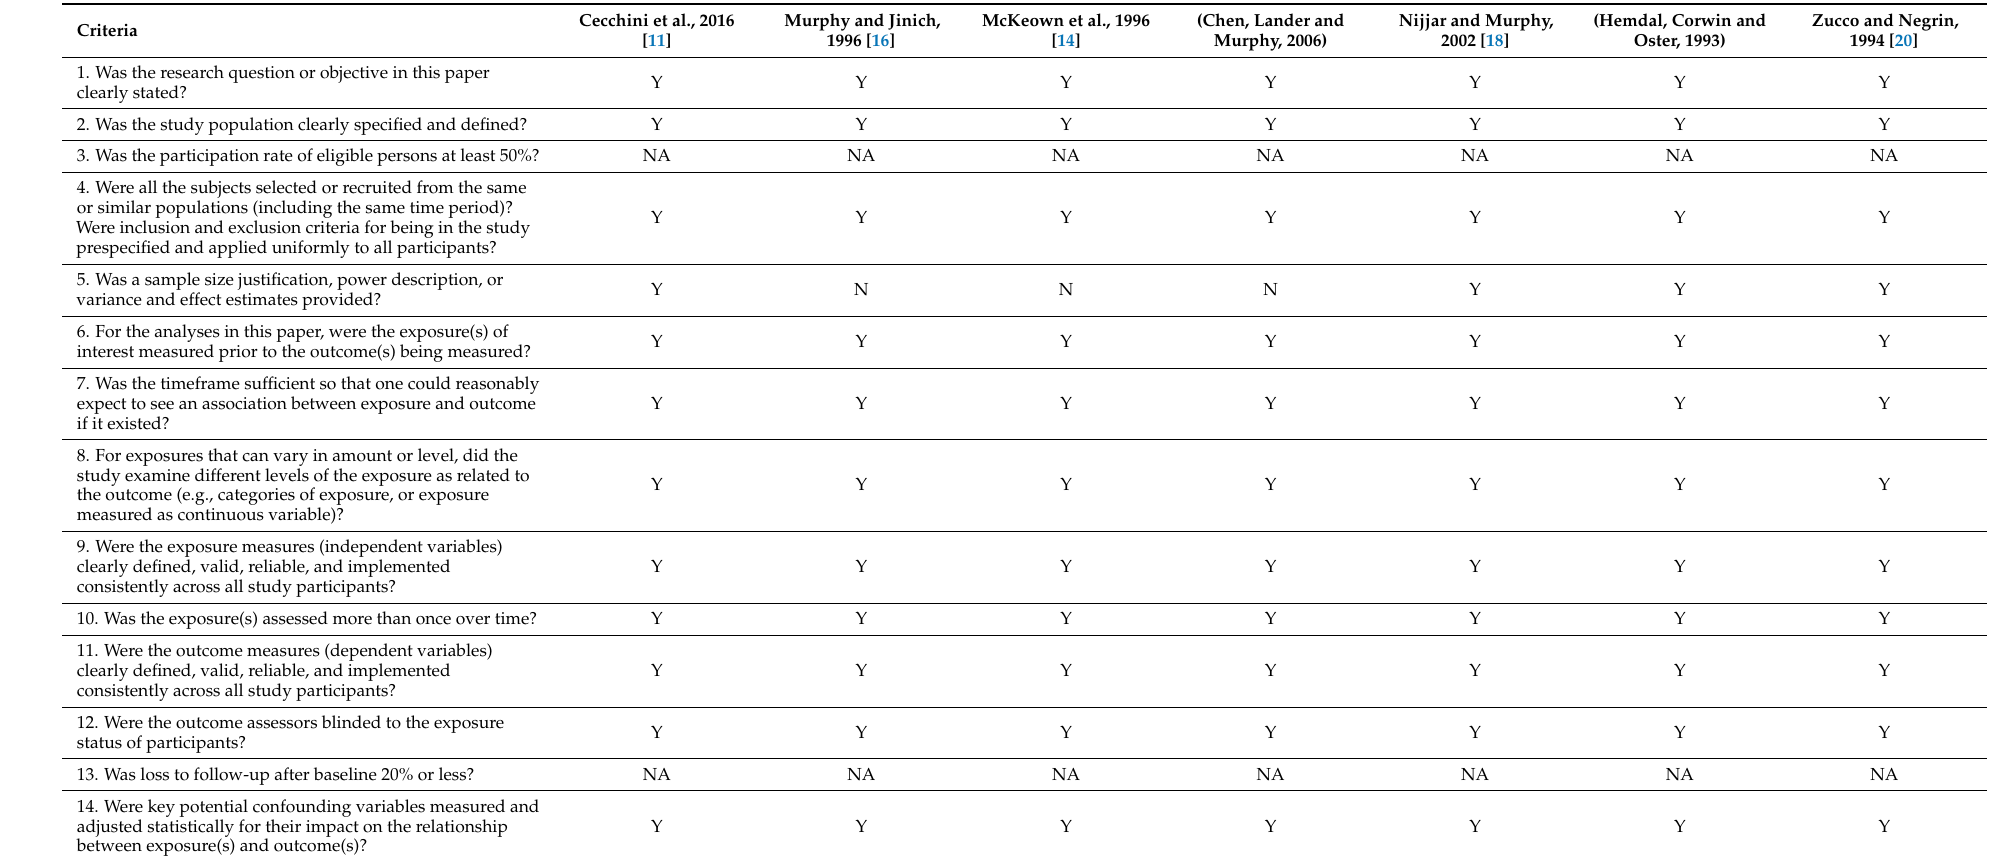
Table A1. Quality Check of Selected